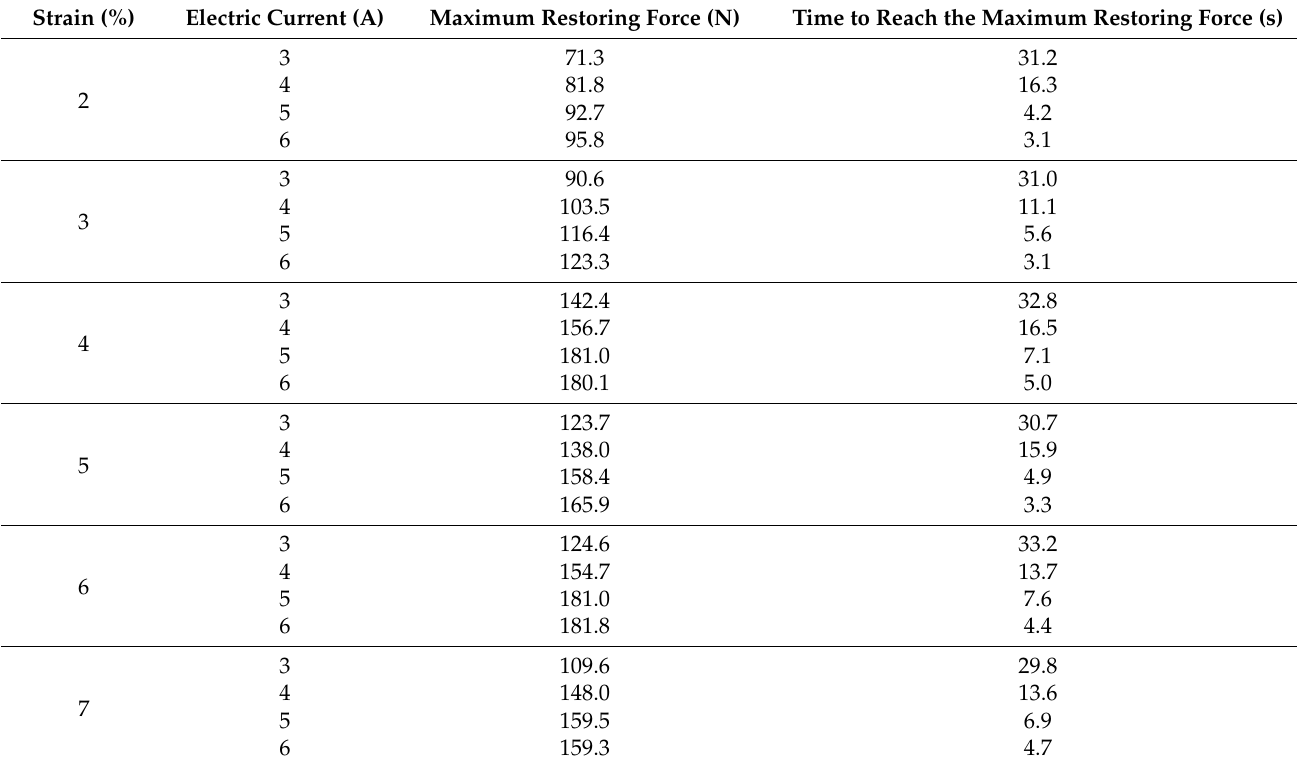
Figure 6. Free recovery rate curve of NiTi wires. Table 4. Maximum restoring force and required time at different electric